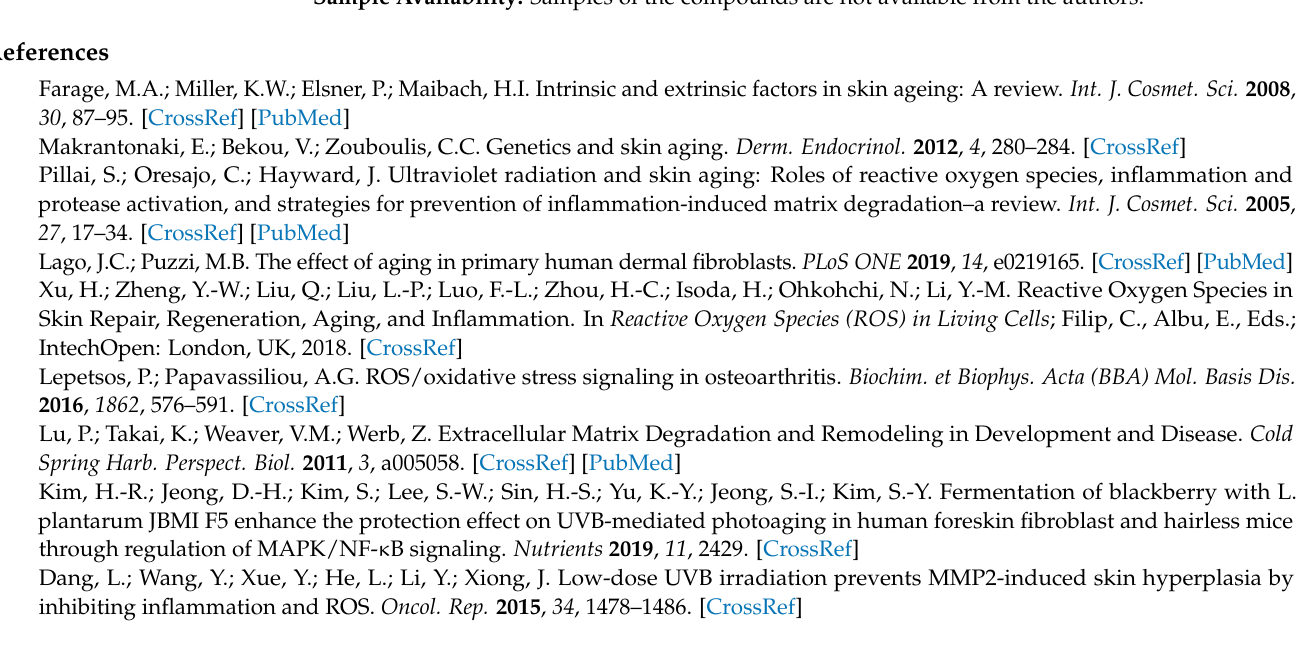
Supplementary Materials: Figure S1: Culture of EPS-producing lactic acid bacteria. Figure S2: High-performance liquid chromatography (HPLC) chromatogram after acid hydrolysis of EPS produced by L. plantarum HY7714 and